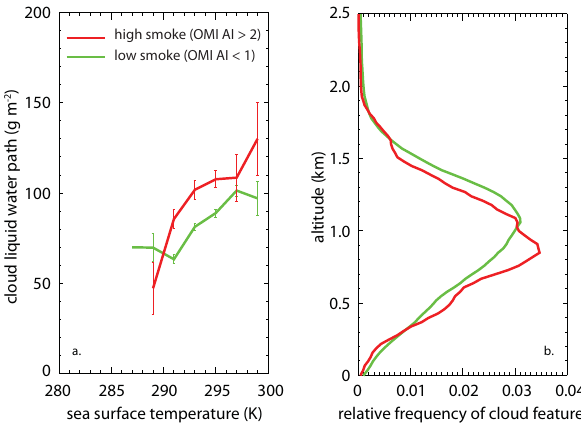
Fig. 5. (a) AMSR-E cloud liquid water path against AMSR-E sea surface temperature and (b) relative frequency of occurrence of CALIPSO cloud features. Both are shown separately for high smoke (red) and low smoke (green) samples. Vertical bars in (a) are the estimated 95% confidence interval based on variability in each SST bin. The total number of low smoke and high smoke CALIPSO cloud features between 0 and 2.5km altitude are 3279831 and 922,596